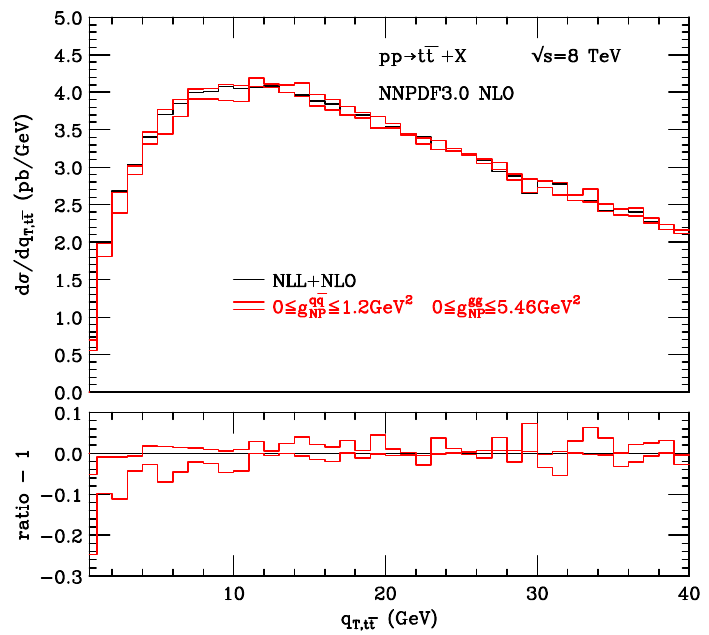
Figure 9. The transverse-momentum cross section dσ/dq T of the t ¯ t pair at the LHC ( √ s = 8 TeV). Comparison of NLL+NLO results at central scales ( µ R = µ F = Q = m t ) without (black line) and with (red band) the inclusion of a NP form factor (0 The lower panel presents the relative effect of the NP form